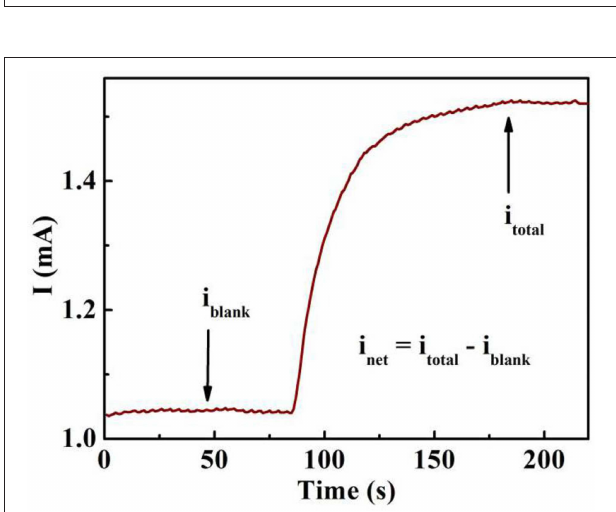
FIGURE 6 | Photocurrent response of a 0.2mM Na 2 SO 4 blank solution (i blank ) and the 0.2mM Na 2 SO 4 solution containing organic compounds (i total ). The step originates from the oxidation of the organic